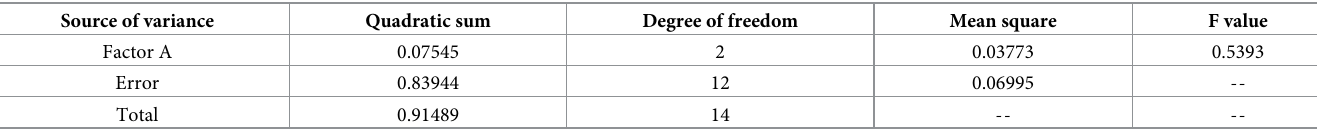
Table 1. Variance Analysis of separation force at different loading